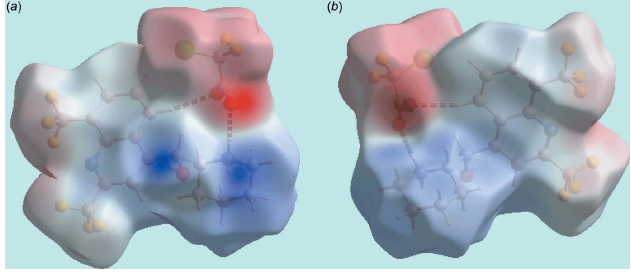
Figure 4 Two views of the Hirshfeld surface of (I) mapped over the electrostatic potential in the range (cid:3) 0.133 to + 0.219 au. The red and blue regions represent negative and positive electrostatic potentials, respectively.